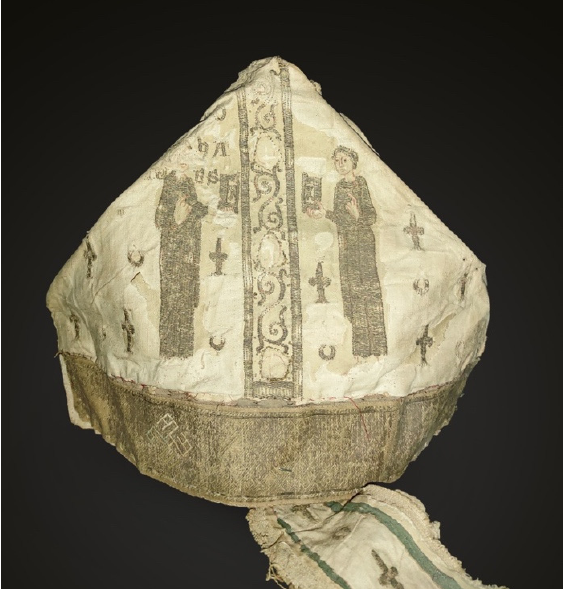
Figure 8. Anagni Mitre, front face with full-length portraits of Becket and St Nicholas. Ancient treas- ury of Anagni Cathedral, now in the cathedral museum, Italy. © by concession of the Chapter of the Basilica Cathedral of Anagni. Photo: Graframan.com.